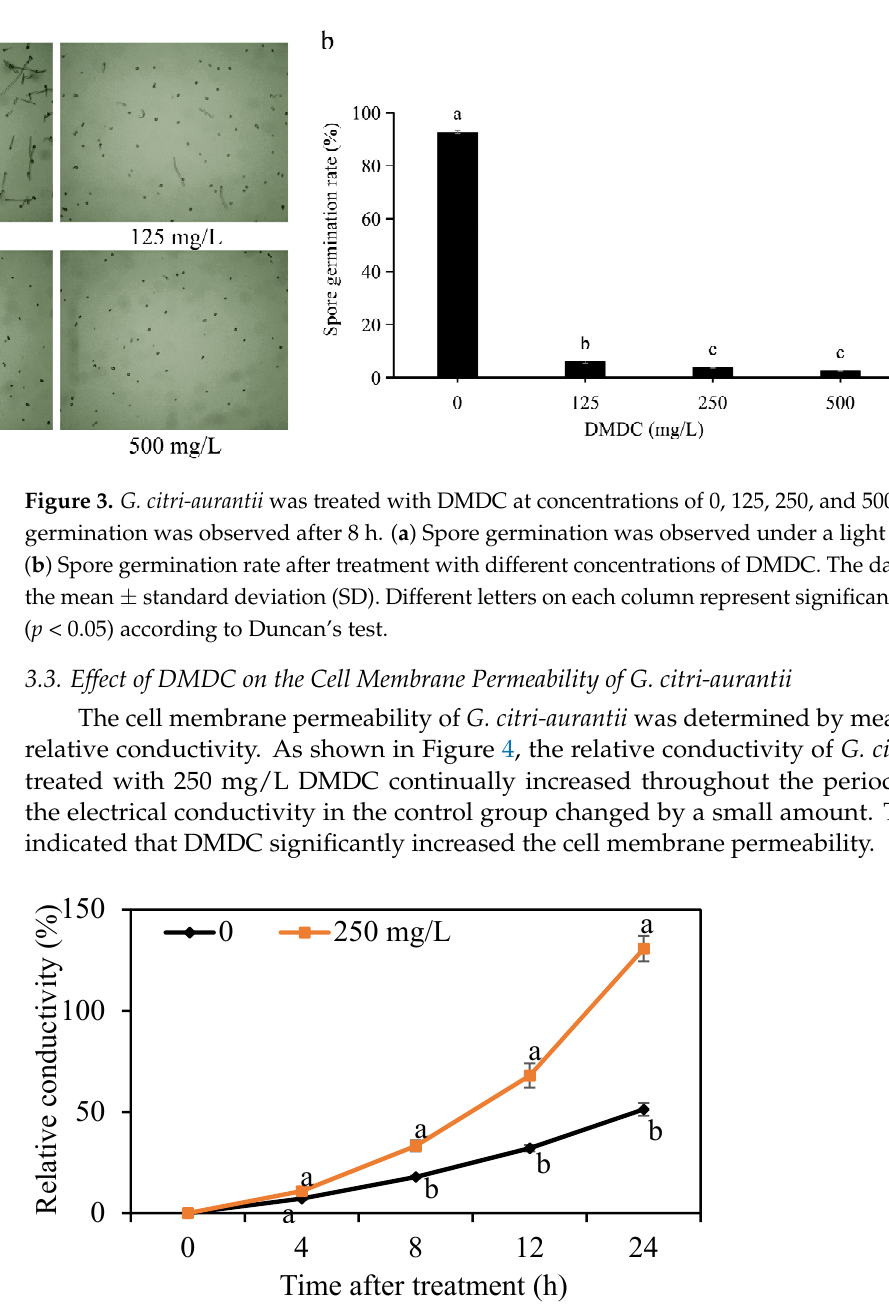
Figure 4. Effect of DMDC on the cell membrane permeability of G. citri-aurantii . The relative conductivity of G. citri-aurantii treated with 250 mg/L DMDC and untreated at 0, 4, 8, 12, and 24 h. The data represent the mean ± standard deviation (SD). Different letters on each column represent significant differences ( p < 0.05 ) according to a t-test.